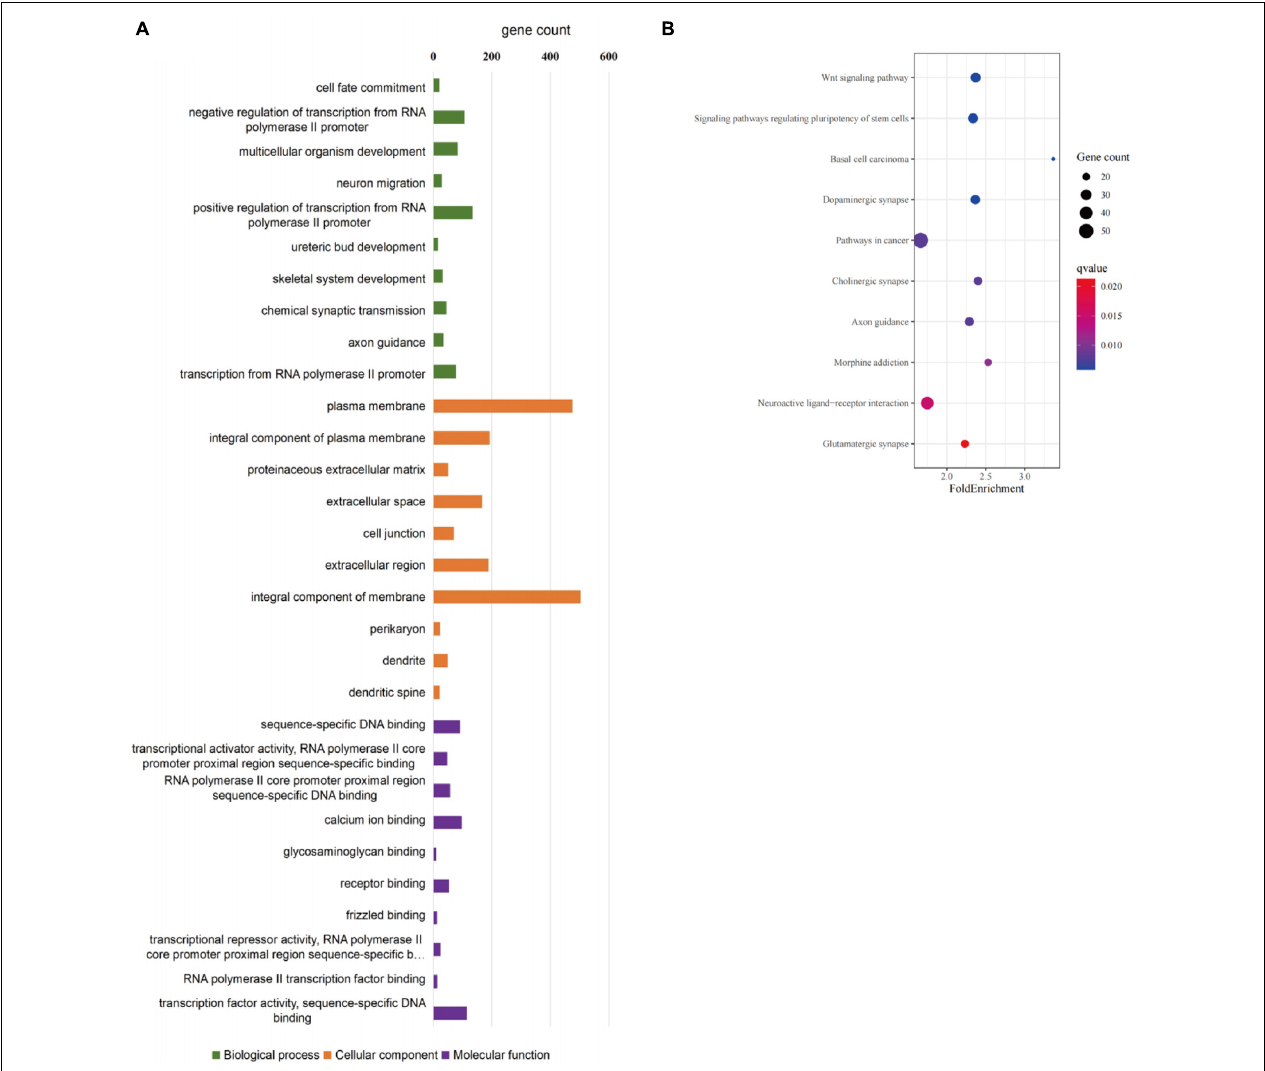
FIGURE 8 | GO enrichment analysis of differentially expressed genes in SOX10 mutant iNCCs. (A) Top 10 most enriched GO terms for biological processes, cellular components, and molecular function. (B) Top 10 most enriched KEGG pathway terms are